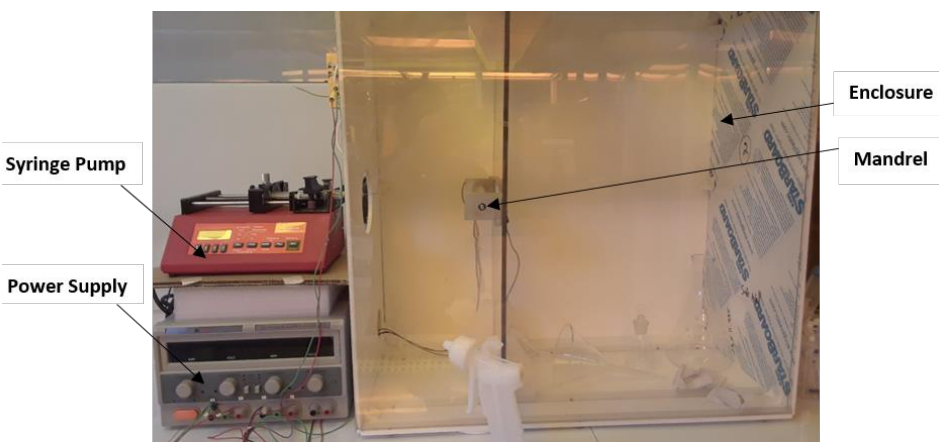
Figure 20. The final electrospinning setup [ 171 ] .